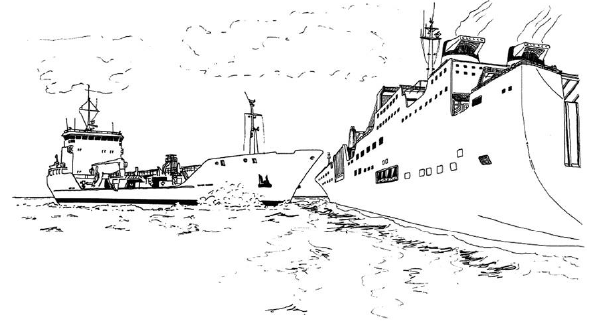
Figure 3: Collision between two ships